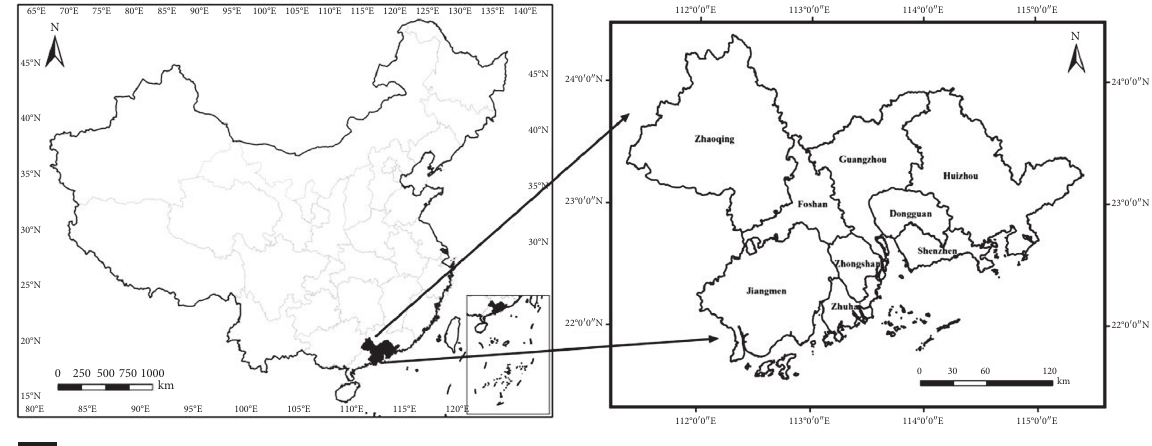
Figure 1: Study area and its location in